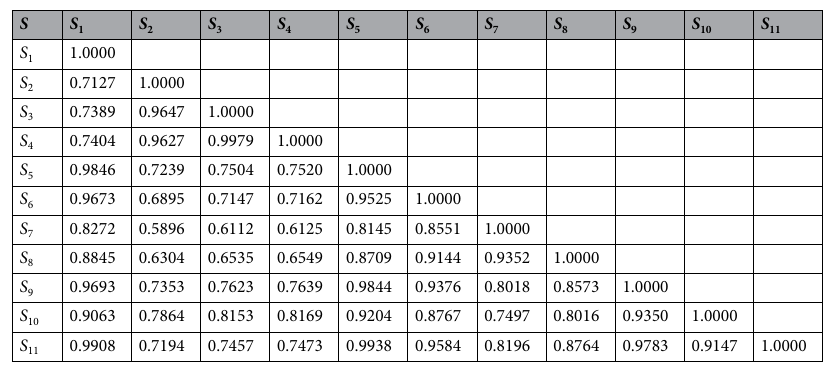
Table 3. Grey close values P ij .